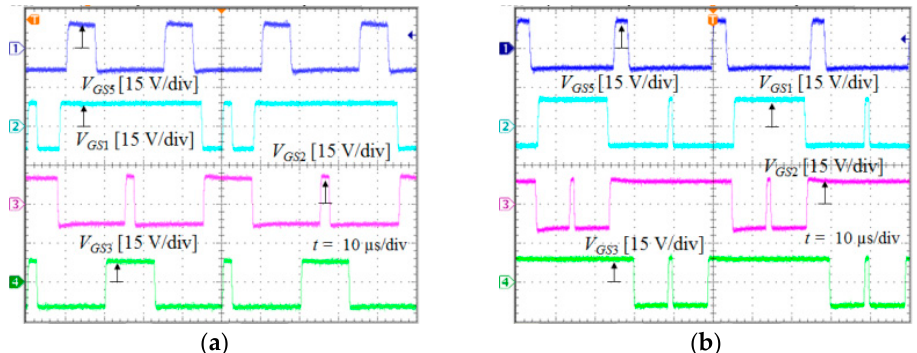
Figure 11. Control signal waveforms when ( a ) V dc = 50 V and ( b ) V dc = 72 V.